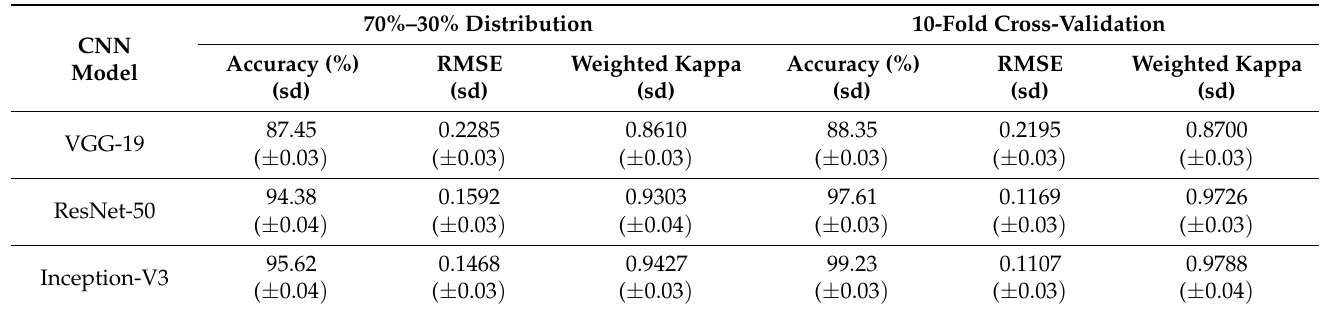
Table 1. Comparison of CNN models using dataset 1 for 40